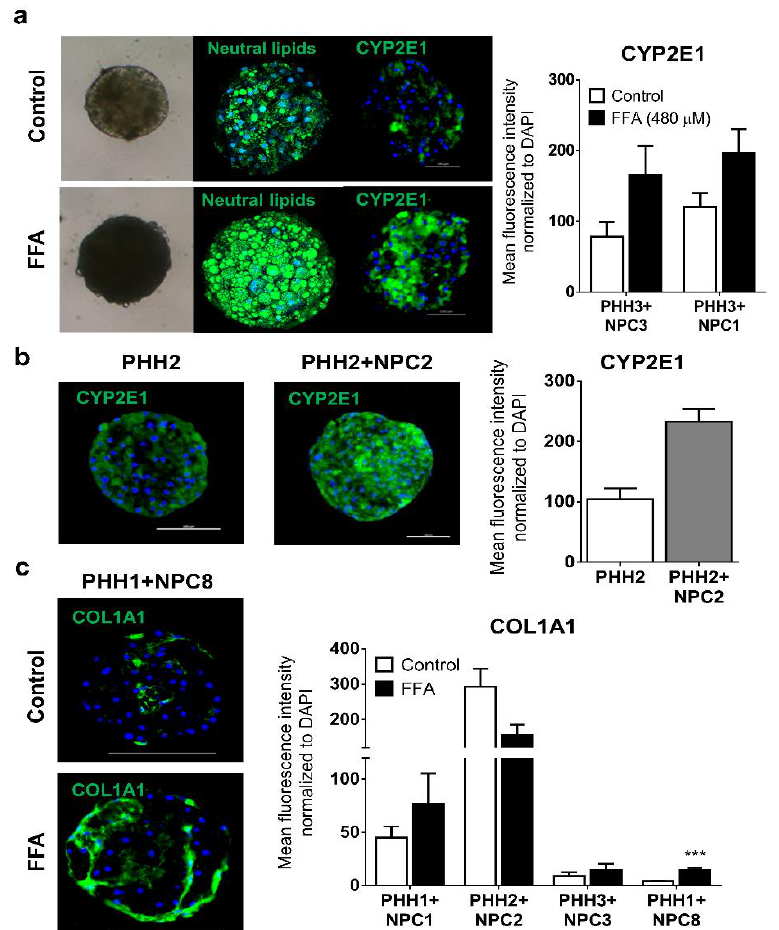
Figure 5. Free fatty acids induce lipid accumulation and can increase expression of CYP2E1, COL1A1, and αSMA. Lipid accumulation in spheroids exposed to FFA was evidenced by staining of neutral lipids, and an increase in CYP2E1 protein expression exemplified in donor 3 ( a ). CYP2E1 also increased in the presence of some NPCs ( b ). Increased COL1A1 protein expression under FFA pressure is exemplified at protein level in PHH1 + NPC8 and quantified across different donors, which demonstrated the influence of inter-individual variability in the baseline expression of these fibrogenic markers and ability to respond to FFA pressure ( c ). *** p < 0.001.